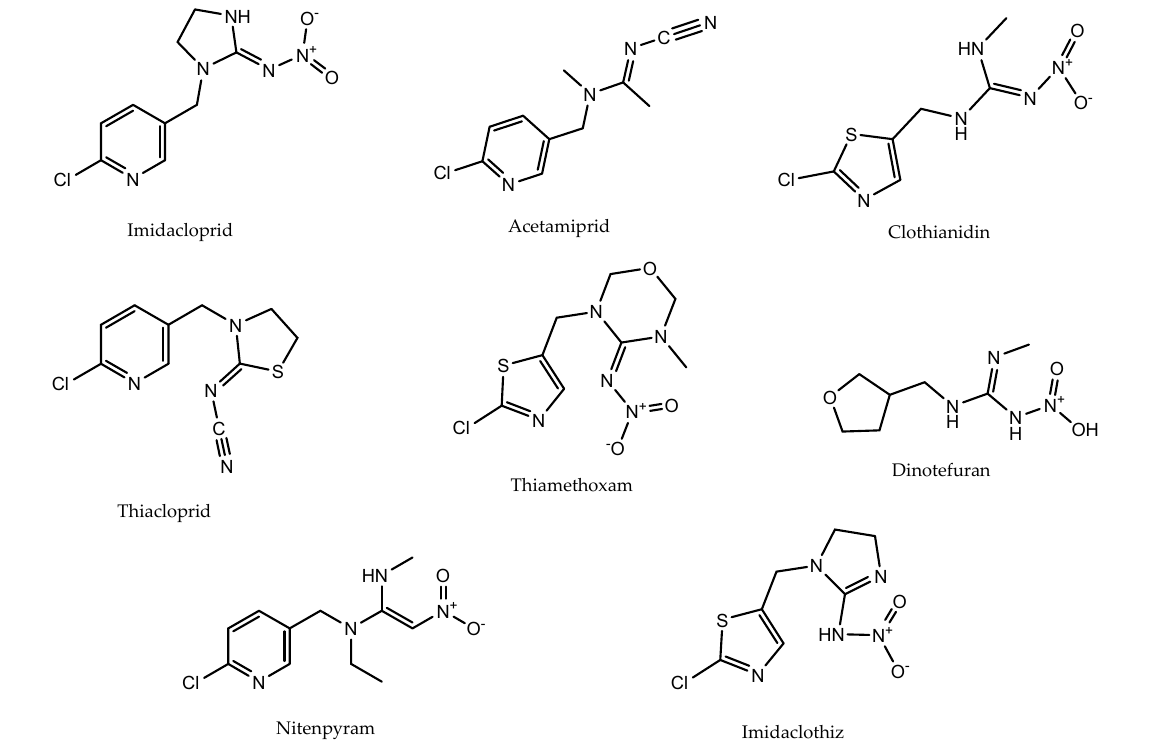
Figure 1. Chemical structures of the eight most relevant neonicotinoid pesticides. It is suggested that both the direct and systemic exposure of honeybees to neonicoti- noids has led to increased mortality amongst bees [7,9]. Although several studies have showed that neonicotinoids including imidacloprid, clothianidin and thiamethoxam are not lethal to bees at field-realistic concentrations, the collective exposure to these neonicotinoids can still affect the bees’ health, stress levels and homing ability [14–16]. Bees are mainly exposed to neonicotinoids by them coming into contact with contaminated plants while foraging, and from there, neonicotinoids can be further transferred to honey, beebread and beeswax